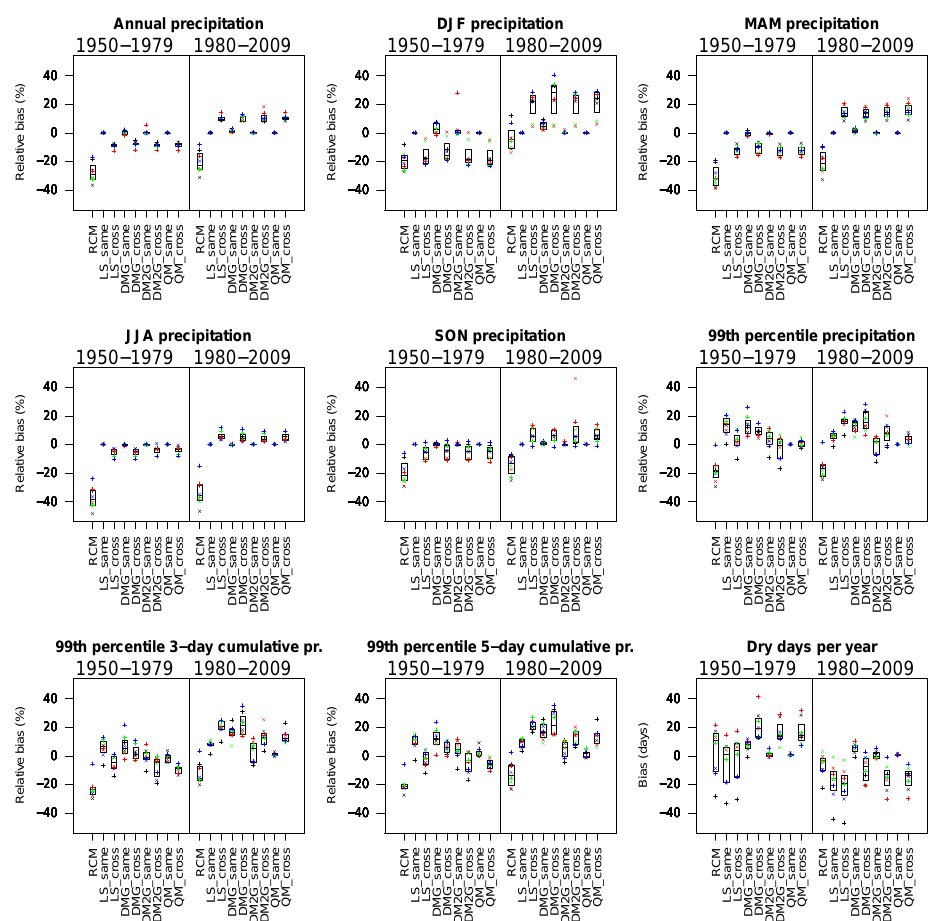
Figure 10. As for Fig. 3, but showing results from the long-term (two 30-year-long) experiments.